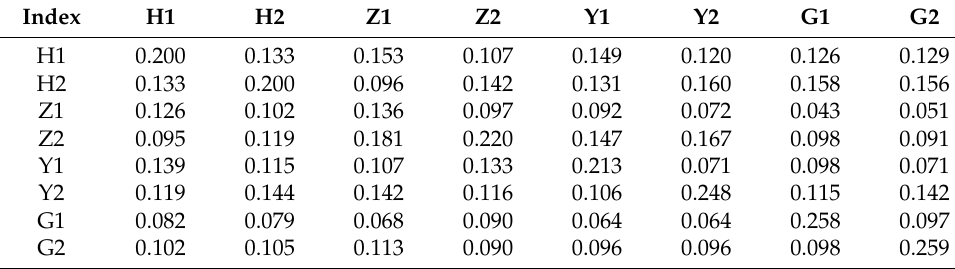
Table 2. Weighted super matrix.